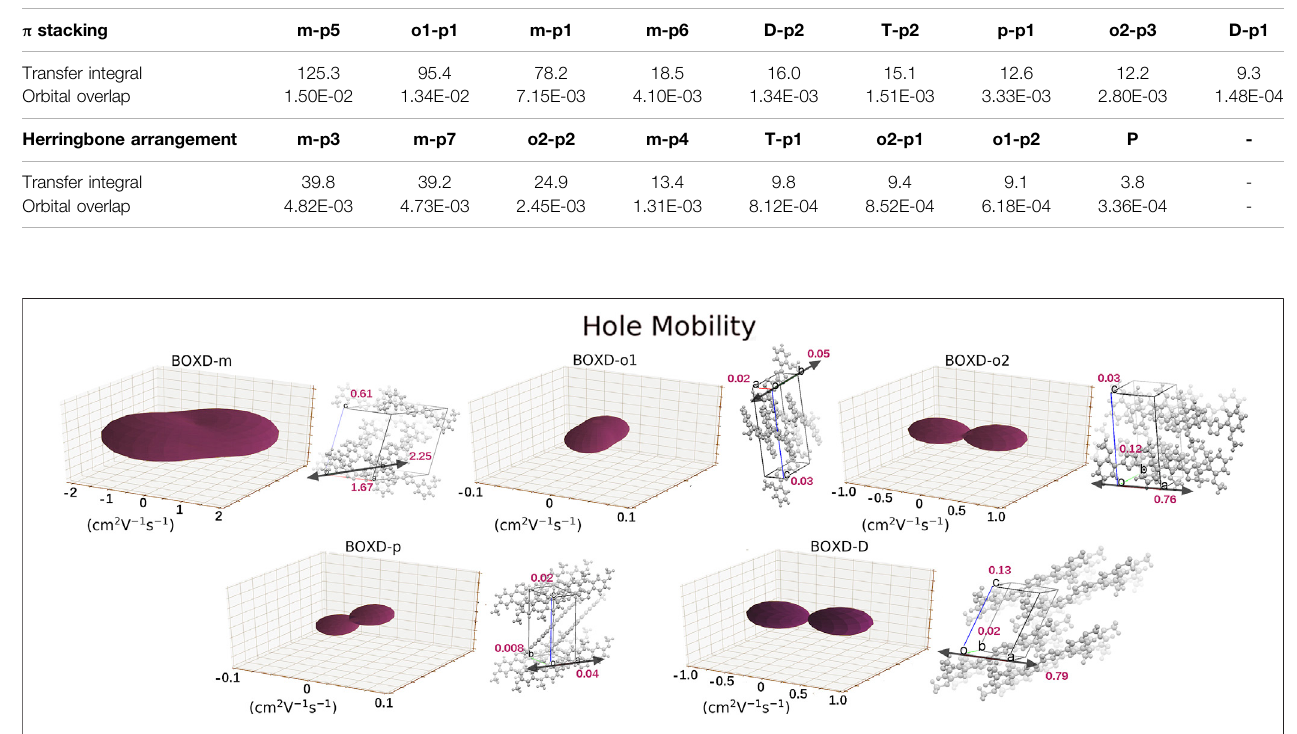
FIGURE 7 | Three-dimensional images of hole mobility in six crystal structures. The hole mobility of BOXD-T is 0 and is not showed here. The mobilities of each direction are next to the crystal cell directions.